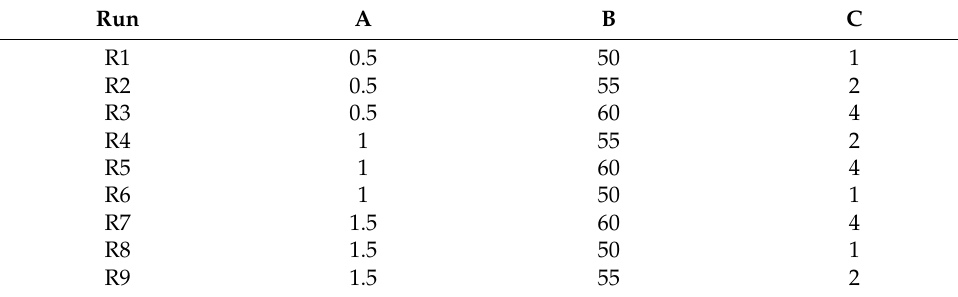
Table 2. Experimental design for the SLPC